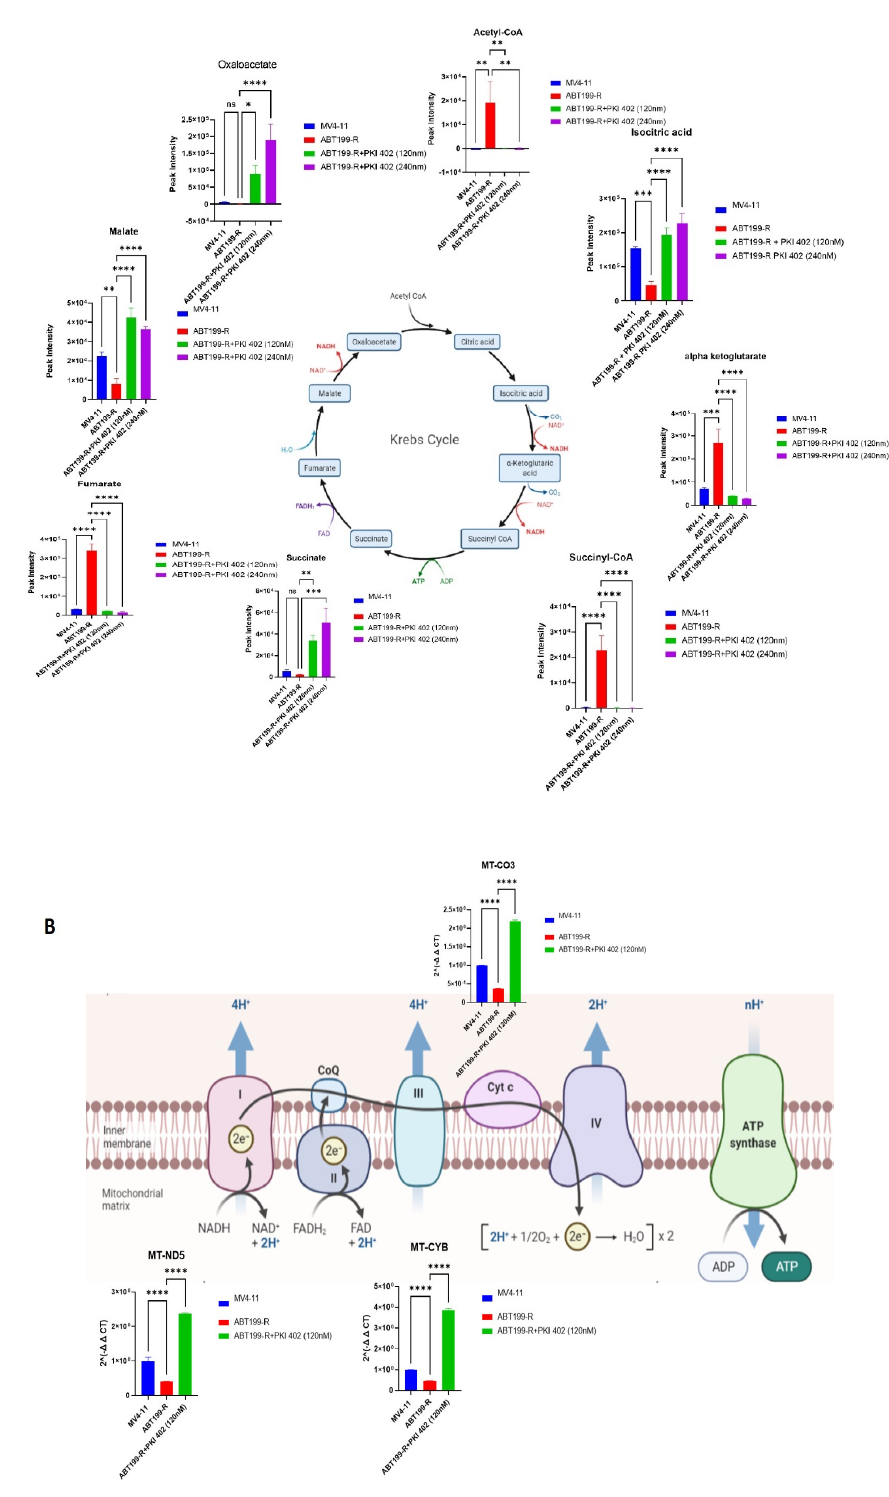
Figure 6. TCA cycle metabolism and OXPHOS are altered in ABT199-R cells. ( A ) The peak intensity of individual metabolites and their quantitative levels involved in the TCA cycle of MV4-11 cells, ABT199-R cells, and ABT199-R cells treated with PKI-402. ( B ) Gene expression (RT-PCR) of various genes involved in mitochondrial OXPHOS. ns = non-significant, * p < 0.05, ** p < 0.01, *** p < 0.001, and **** p <